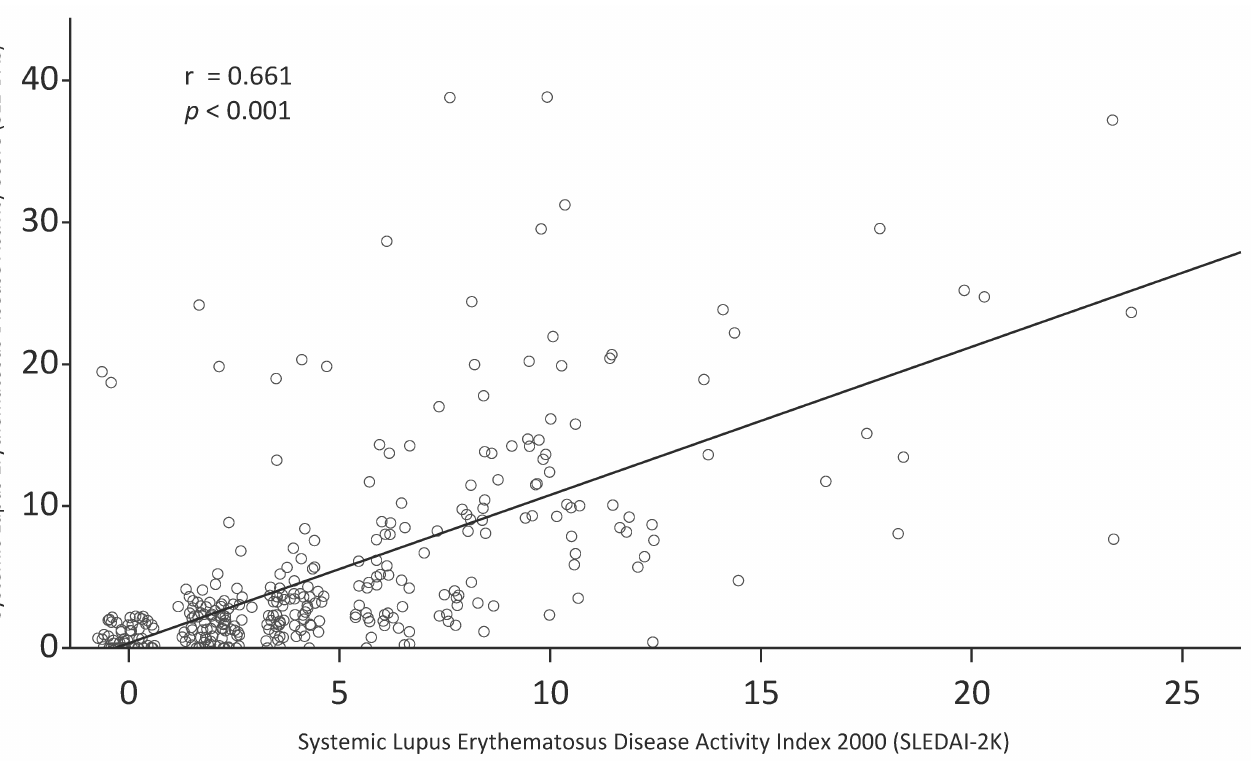
Figure 1. Scatter plot of Systemic Lupus Erythematosus Disease Activity Index 2000 (SLEDAI-2K) and Systemic Lupus Erythematosus Disease Activity Score (SLE-DAS).